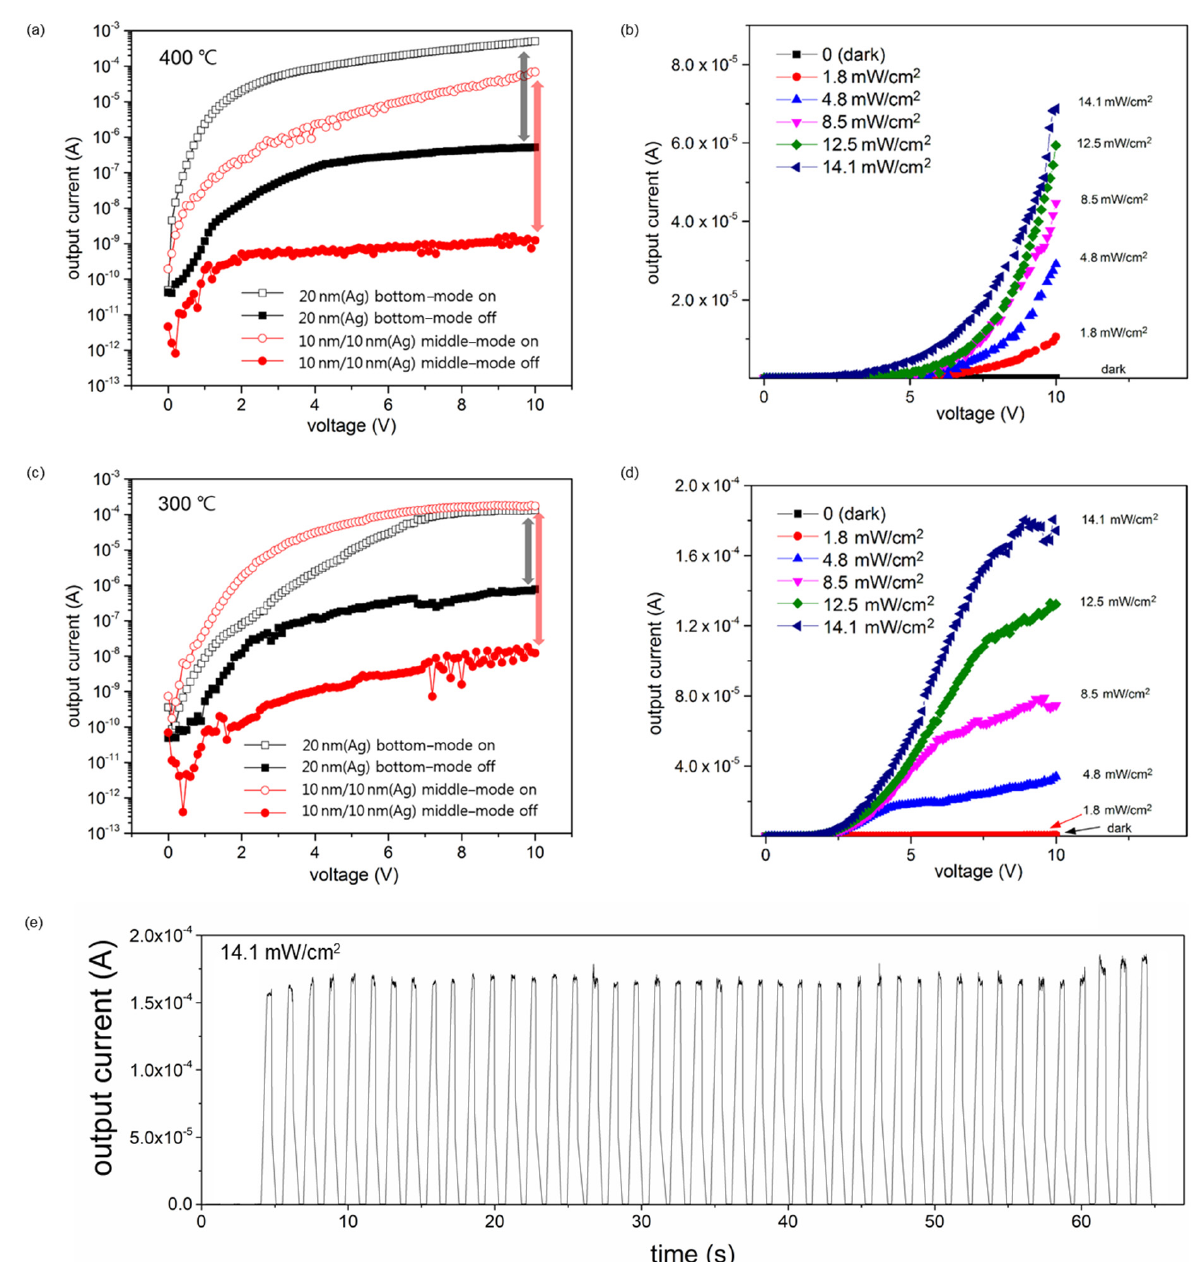
Figure 5. ( a ) Output characteristics of the bottom-mode device with 20 nm (top) of Ag film and middle-mode device with 10 nm (top)/10 nm (bottom) of Ag film, both annealed at 400 ◦ C. ( b ) Output characteristics of the middle-mode device with 10 nm (top)/10 nm (bottom) of Ag film annealed at 400 ◦ C under visible light illumination with various intensities. ( c ) Output characteristics of the bottom-mode device with 20 nm (top) of Ag film and middle-mode device with 10 nm (top)/10 nm (bottom) of Ag film, both annealed at 300 ◦ C. ( d ) Output characteristics of the middle-mode device with 10 nm (top)/10 nm (bottom) of Ag film annealed at 300 ◦ C under visible light illumination with various intensities. The on and off-currents of ( a , c ) were measured under visible light illumination with an intensity of 14.1 mW/cm 2 . The output currents of ( b , d ) were measured under visible light illumination with various intensities of 0.0 (dark), 1.8, 4.8, 8.5, 12.5, and 14.1 mW/cm 2 . ( e ) Switching test curve of the middle-mode device with 10 nm (top)/10 nm (bottom) of Ag film annealed at 300 ◦ C. The device responded 43 cycles for 60 s under visible light illumination with an intensity of 14.1 mW/cm 2